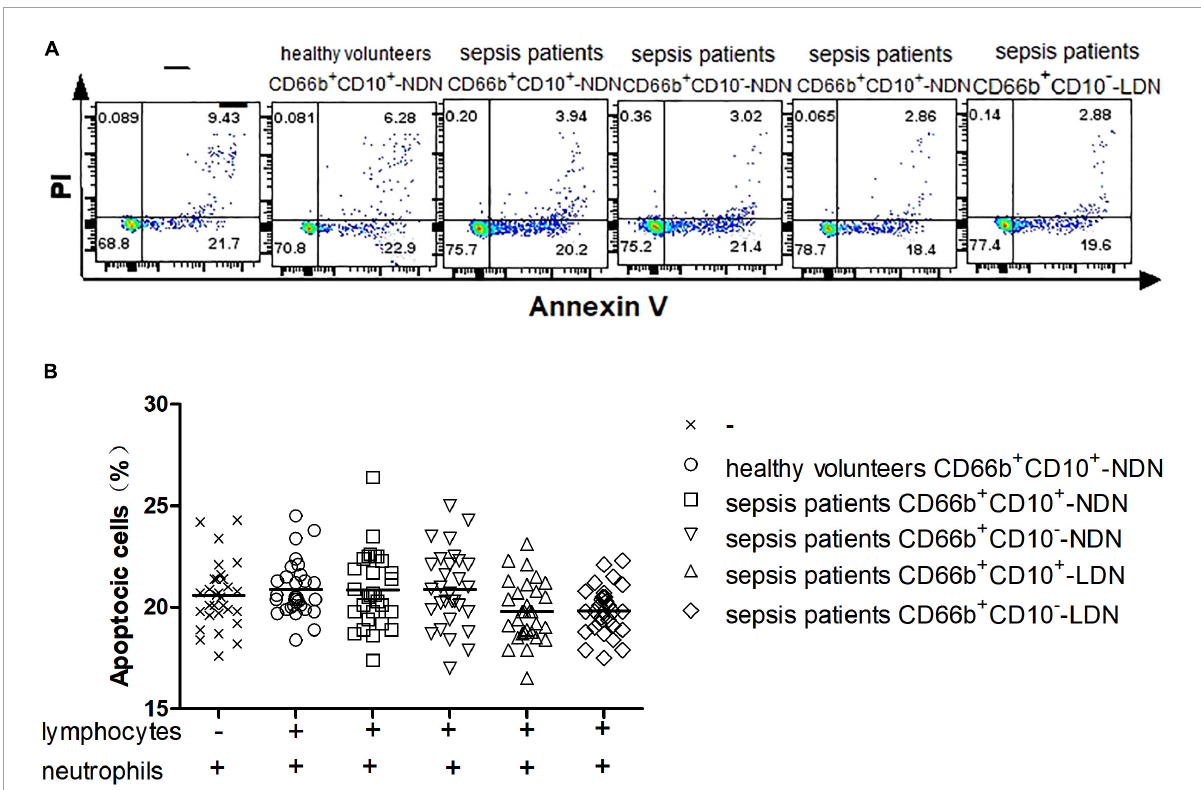
FIGURE5 (A) Flow cytometry chart of the effect of different neutrophil subsets on lymphocyte apoptosis in healthy volunteers. (B) Comparison of the frequencies of apoptotic lymphocytes co-cultured with or without different neutrophil subsets. There was no significant difference among the six groups ( P > 0.05).